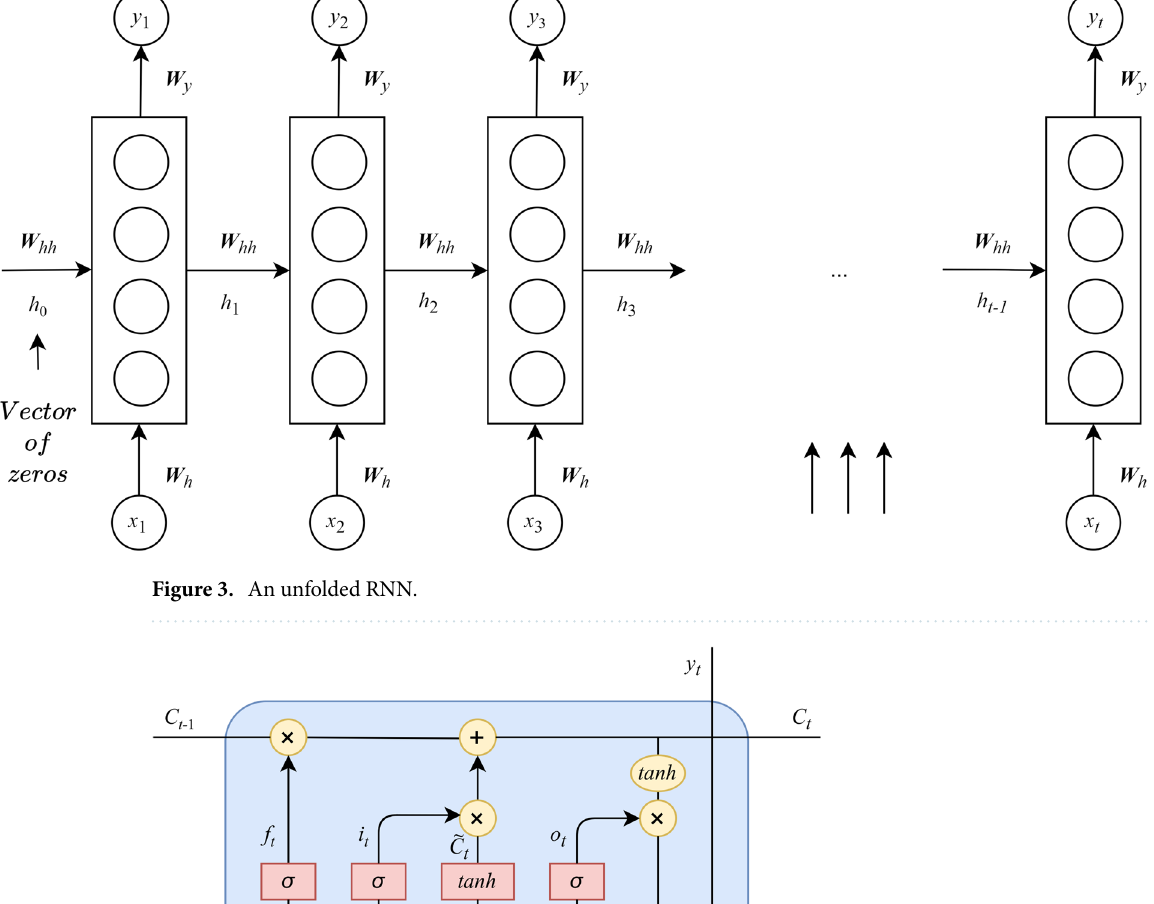
Figure 4. The structure of an LSTM